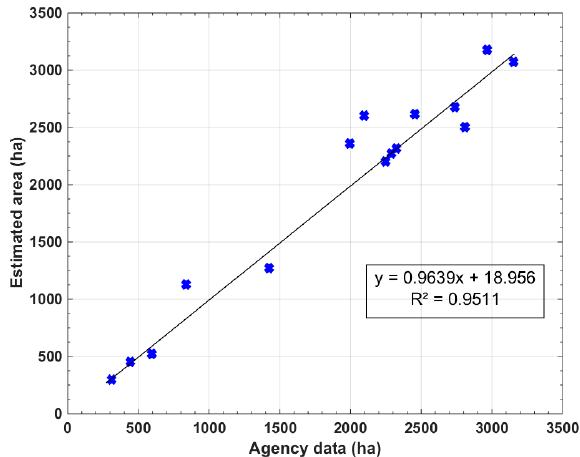
Figure 14. Estimated area in Autumn-Winter crop by CKS vs. agency data of 15 communes in Thoai Son districts, An Giang Province. Black line represents the linear regression between two datasets.